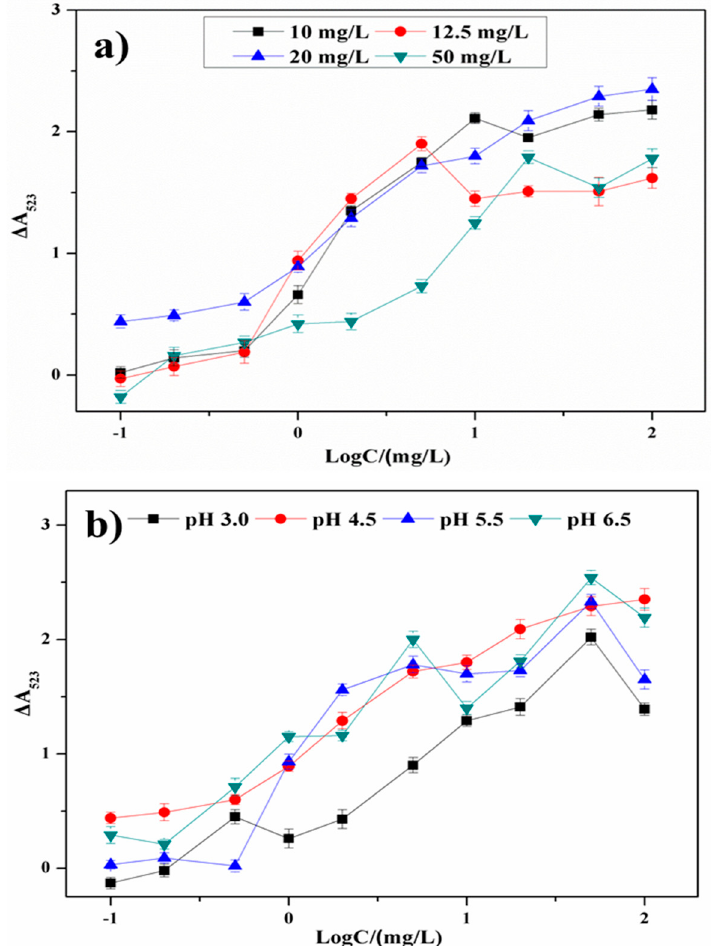
Figure 5. The plots of ∆ A 523 versus chlorsulfuron concentration under ( a ) different concentration of acetamiprid and ( b ) different pH condition.